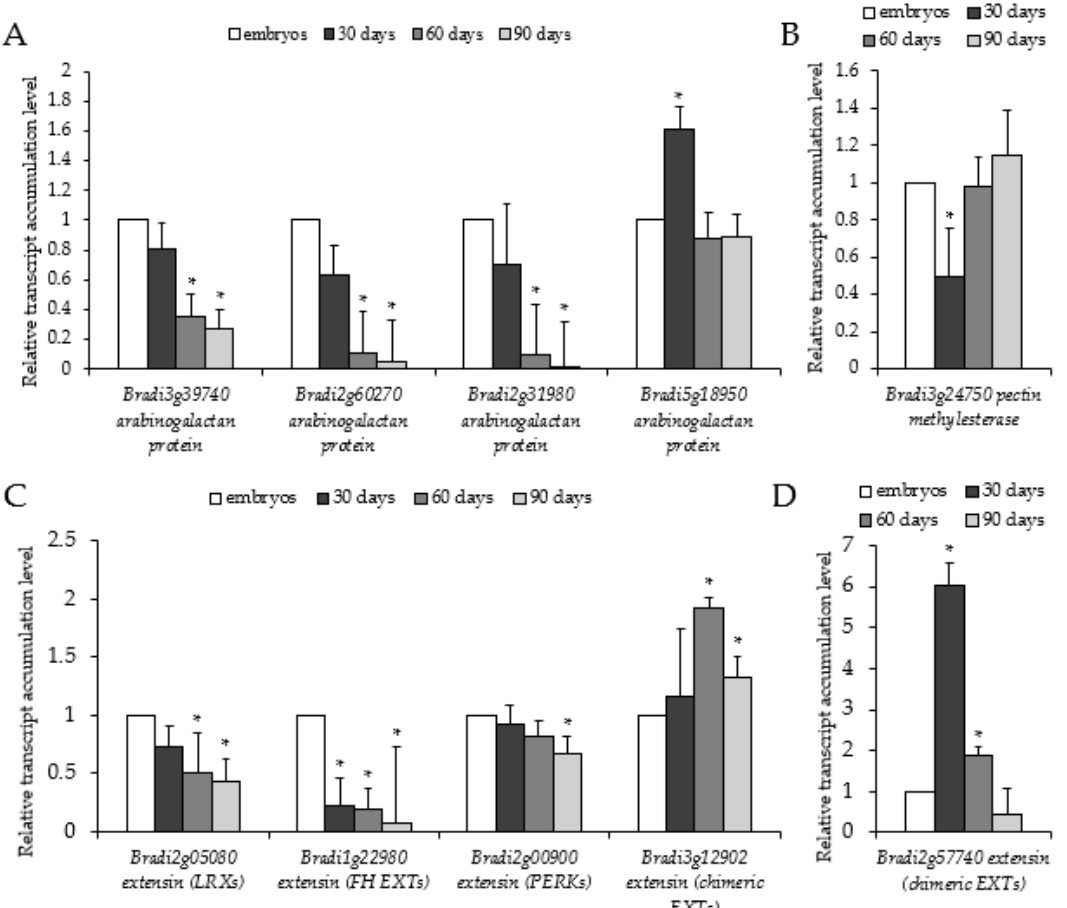
Figure 4. Relative transcript accumulation levels of genes associated with cell wall architecture, i.e., AGPs ( Bradi3g39740 , Bradi2g60270 , Bradi2g31980 , and Bradi5g18950 ), EXTs ( Bradi2g05080 , Bradi1g22980 , Bradi2g00900 , Bradi3g12902 , and Bradi2g57740 ), and PECTIN METHYLESTERASE ( Bradi3g24750 )), on the 30th, 60th, and 90th day of cultivation. Relative transcript accumulation levels of ( A ) AGPs , ( B ) EXTs , ( C ) PECTIN METHYLESTERASE , ( D ) chimeric EXT Bradi3g12902 . The relative transcript accumulation levels were normalised to an internal control ( AK437296 , gene encoding for ubiquitin) and calibrated to the control (explants, zygotic embryos); *: value is significantly different from the control (Student’s t -test, p < 0.05; n = 3 ± SD).